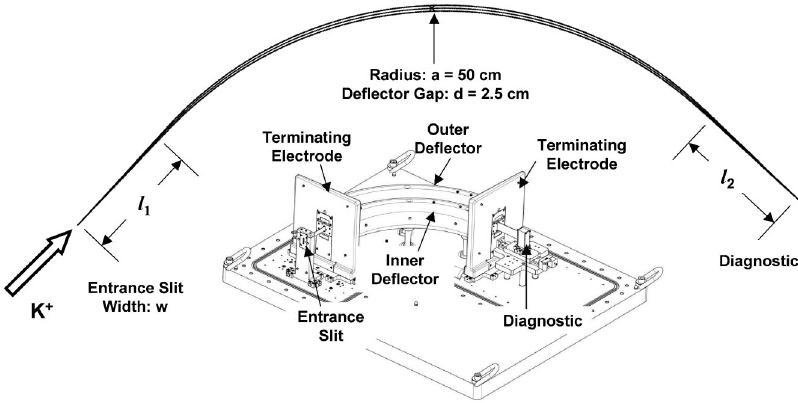
FIG. 3. Schematic of the electrostatic energy analyzer used on